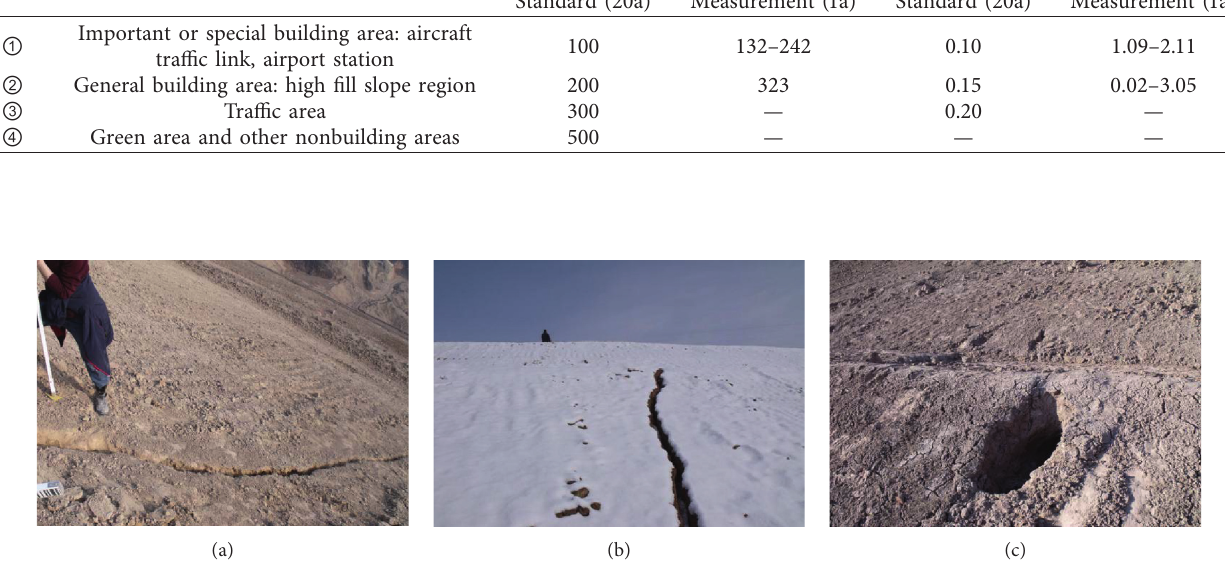
Figure 19: Cracks and doline between the boundary of the fill and the excavation. (a) Cracks between the fill and the foundation soil. (b) Cracks in the fill. (c) Doline in the fill.